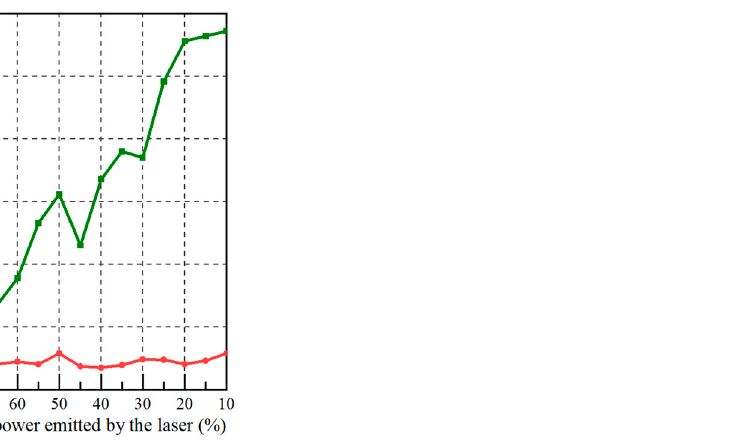
Figure 10. RMS of walk error under di ff erent laser powers based on the two method measurements.